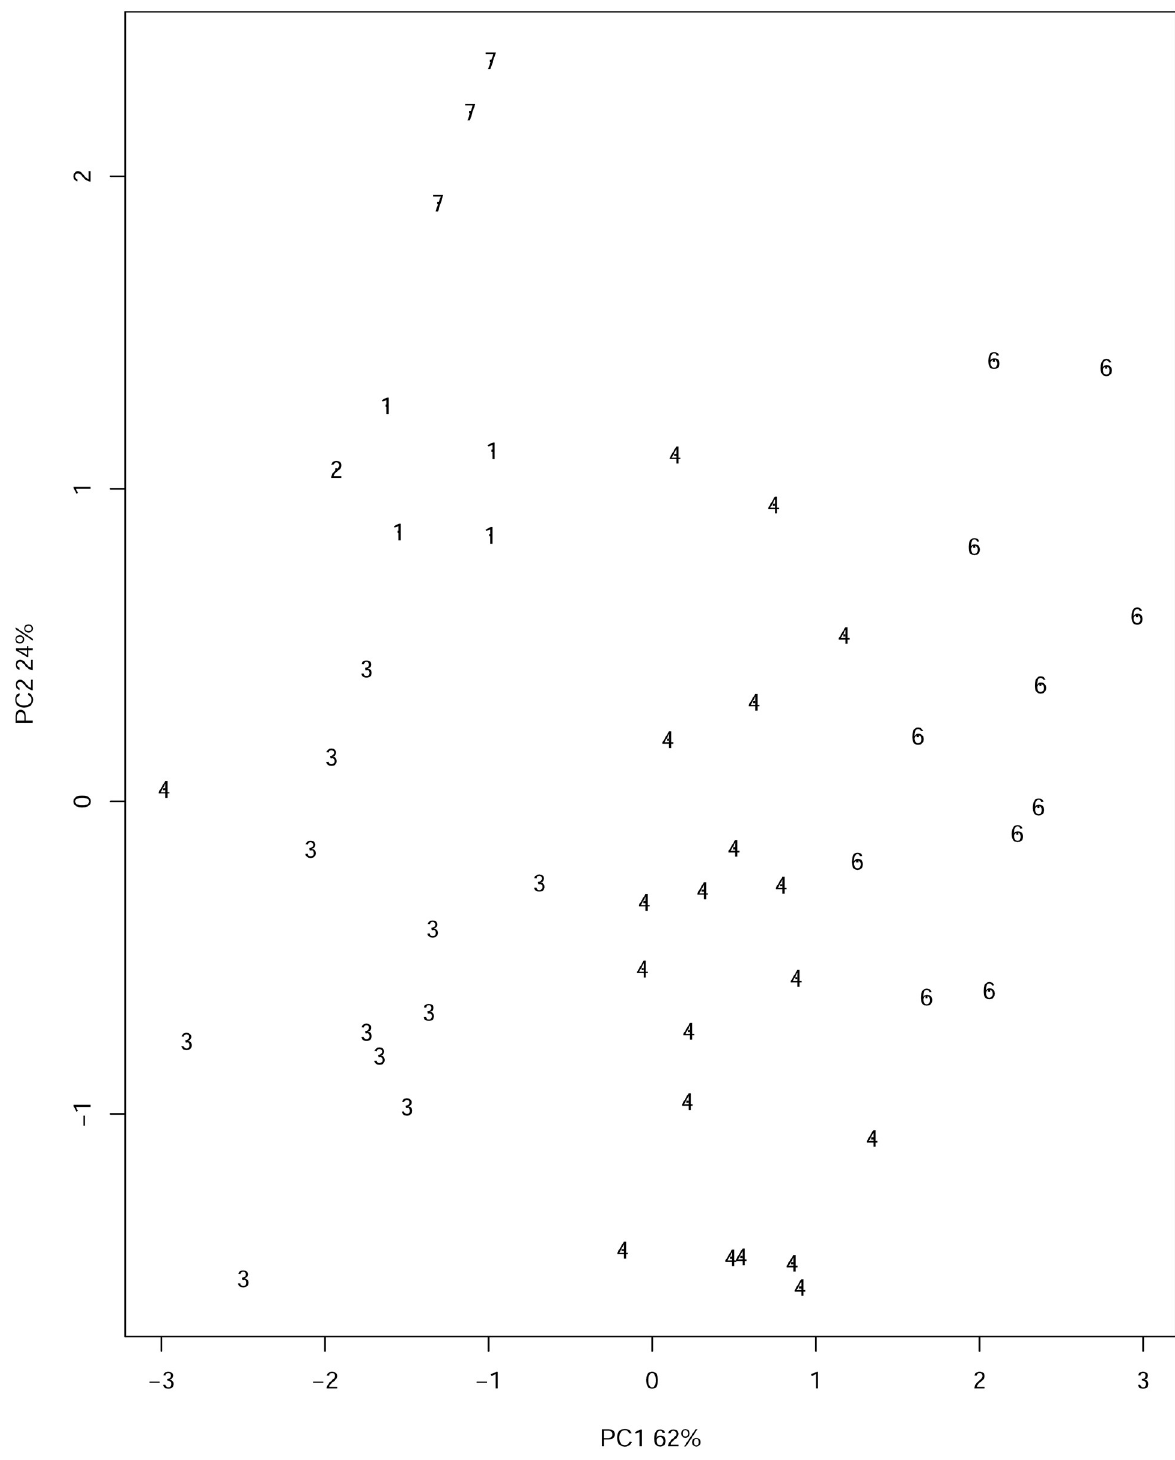
Fig 11. US arrests clustering from the Hungarian algorithm; there are 7 clusters.